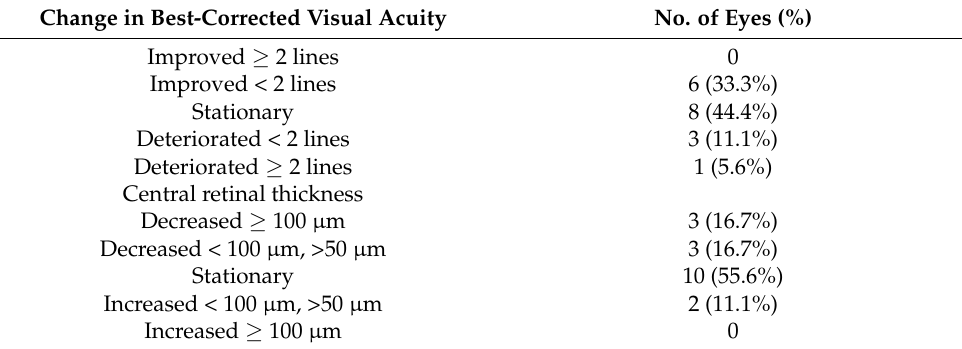
Table 2. Change in best-corrected visual acuity and central retinal thickness in patients with aflibercept-resistant polypoidal choroidal vasculopathy after switching to